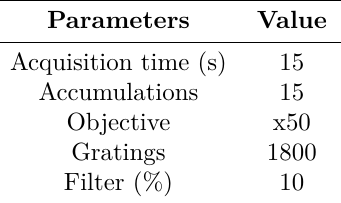
Table 2. Raman spectroscopy parameters